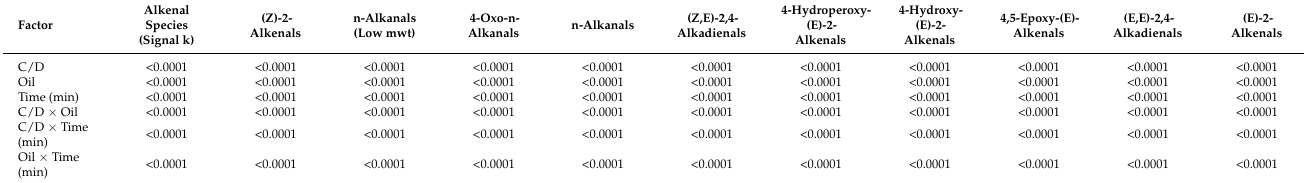
Table 5. Statistical significance of main factors (continuous (C) versus discontinuous (D) thermal- stressing methods (C/D), oil type and heating time (min), along with their three first-order interaction effects, obtained from an ANOVA analysis of the aldehydic LOP dataset (Model